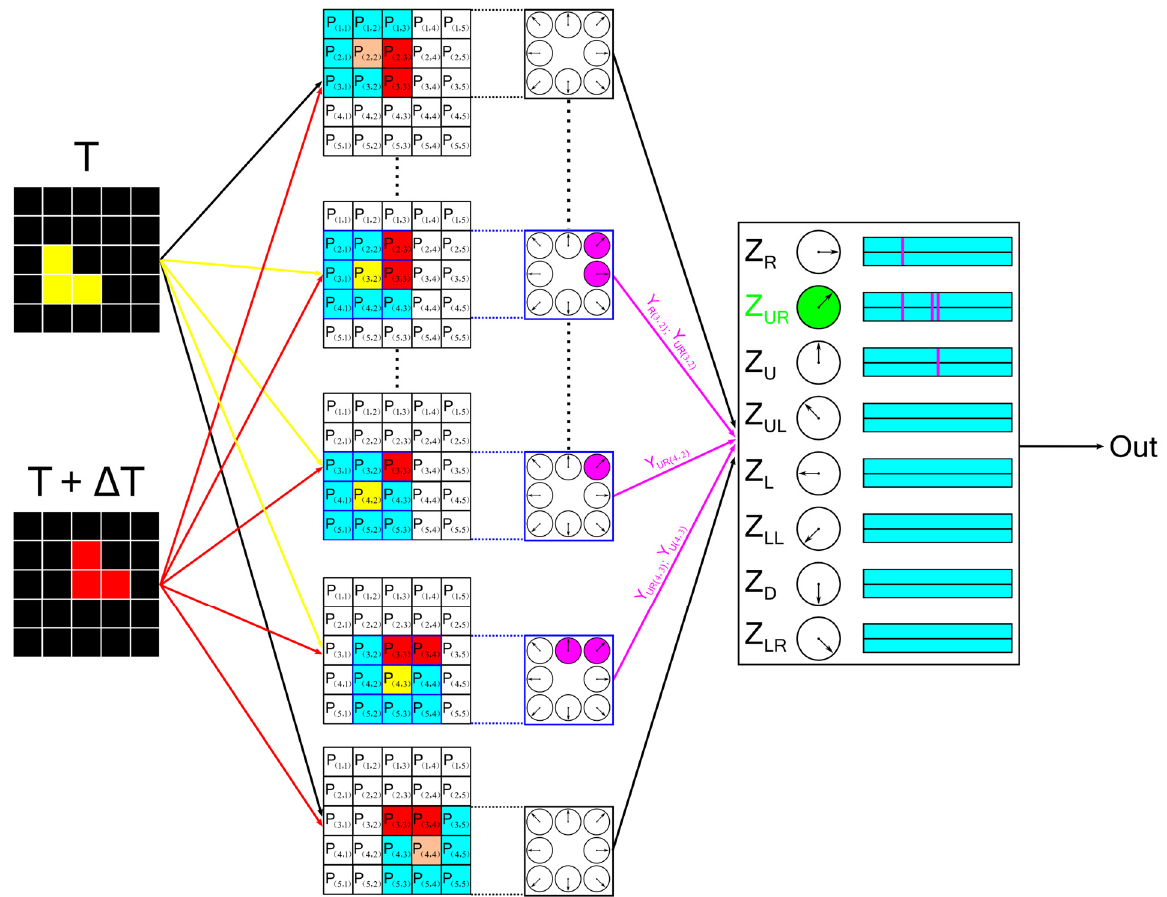
Figure 4. Flowchart of the AVS in detecting 3-pixel object.